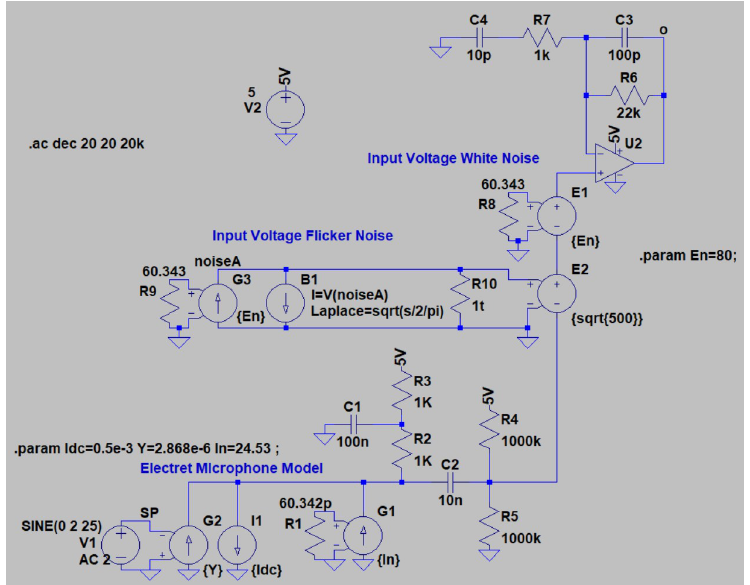
Figure 8. Simulation model in LTspice. Table 2. Model parameters for MAX4466 from Maxim Integrated. Datasheet